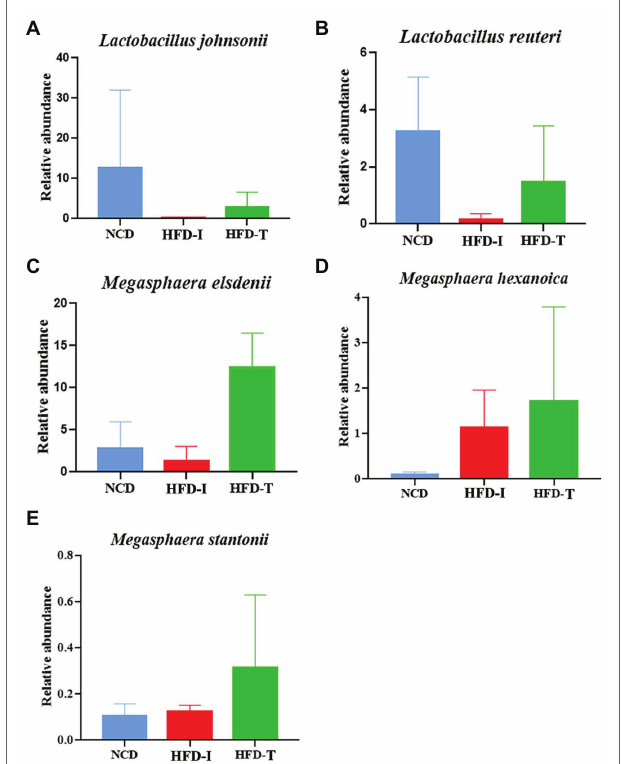
FIGURE 4 | The relative abundance of selected species in the gut microbiota in NCD, HFD-I, and HFD-T monkeys. Lactobacillus johnsonii (A) , Lactobacillus